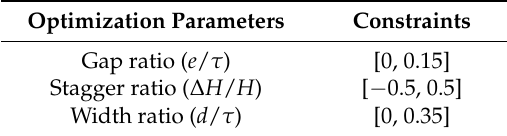
Table 2. Optimization parameters of the novel magnet